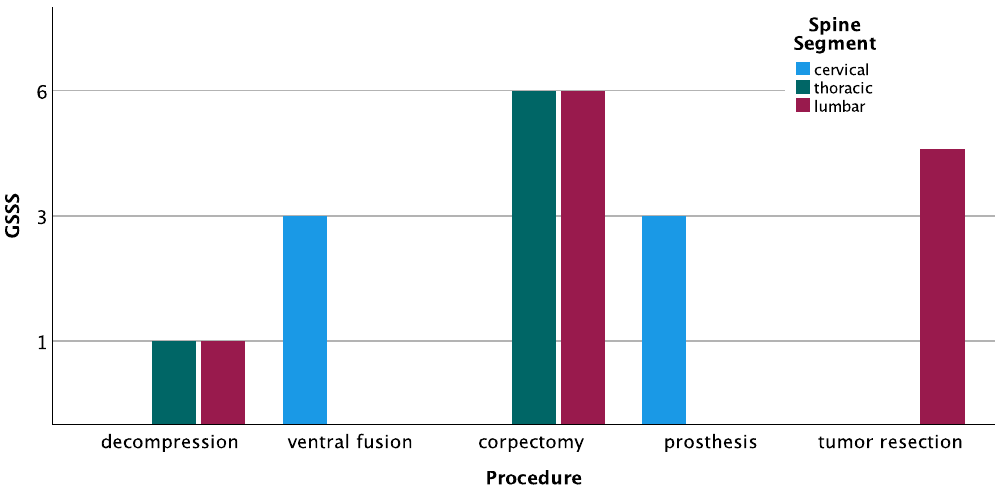
Figure 1. Case complexity based on spine segment and GSSS.